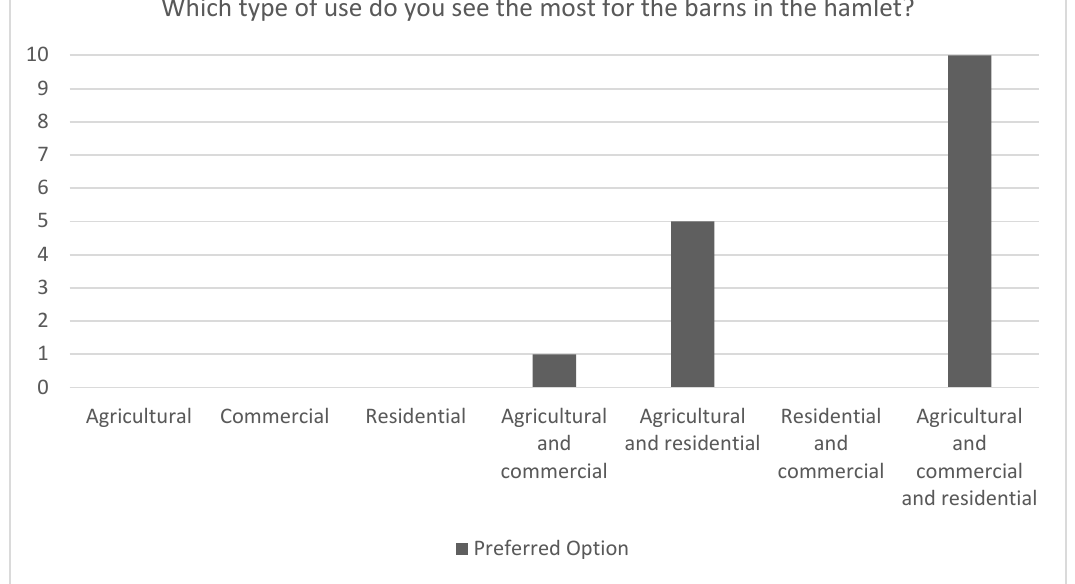
Figure 18: Results of the question on the preferred type of use for barns in Kirchbühl For the type of use envisaged for the barns in the hamlet, there was a clear preference (10 out of 16 votes) for a mix of agricultural, commercial and residential